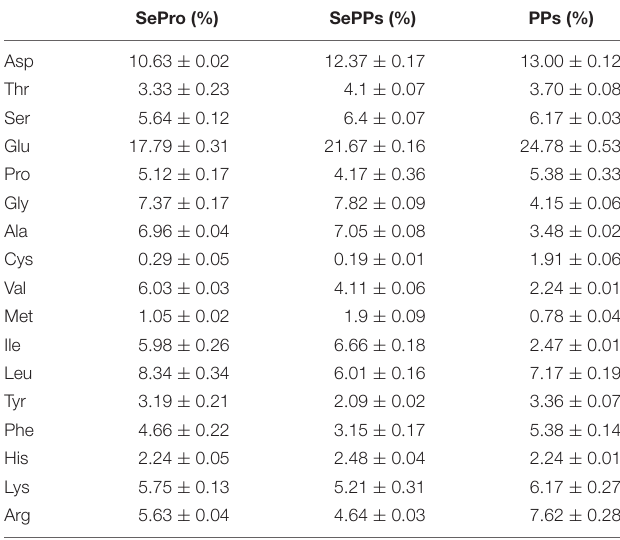
TABLE 1 | The amino acid compositions (%) in SePro, SePPs, and PPs.